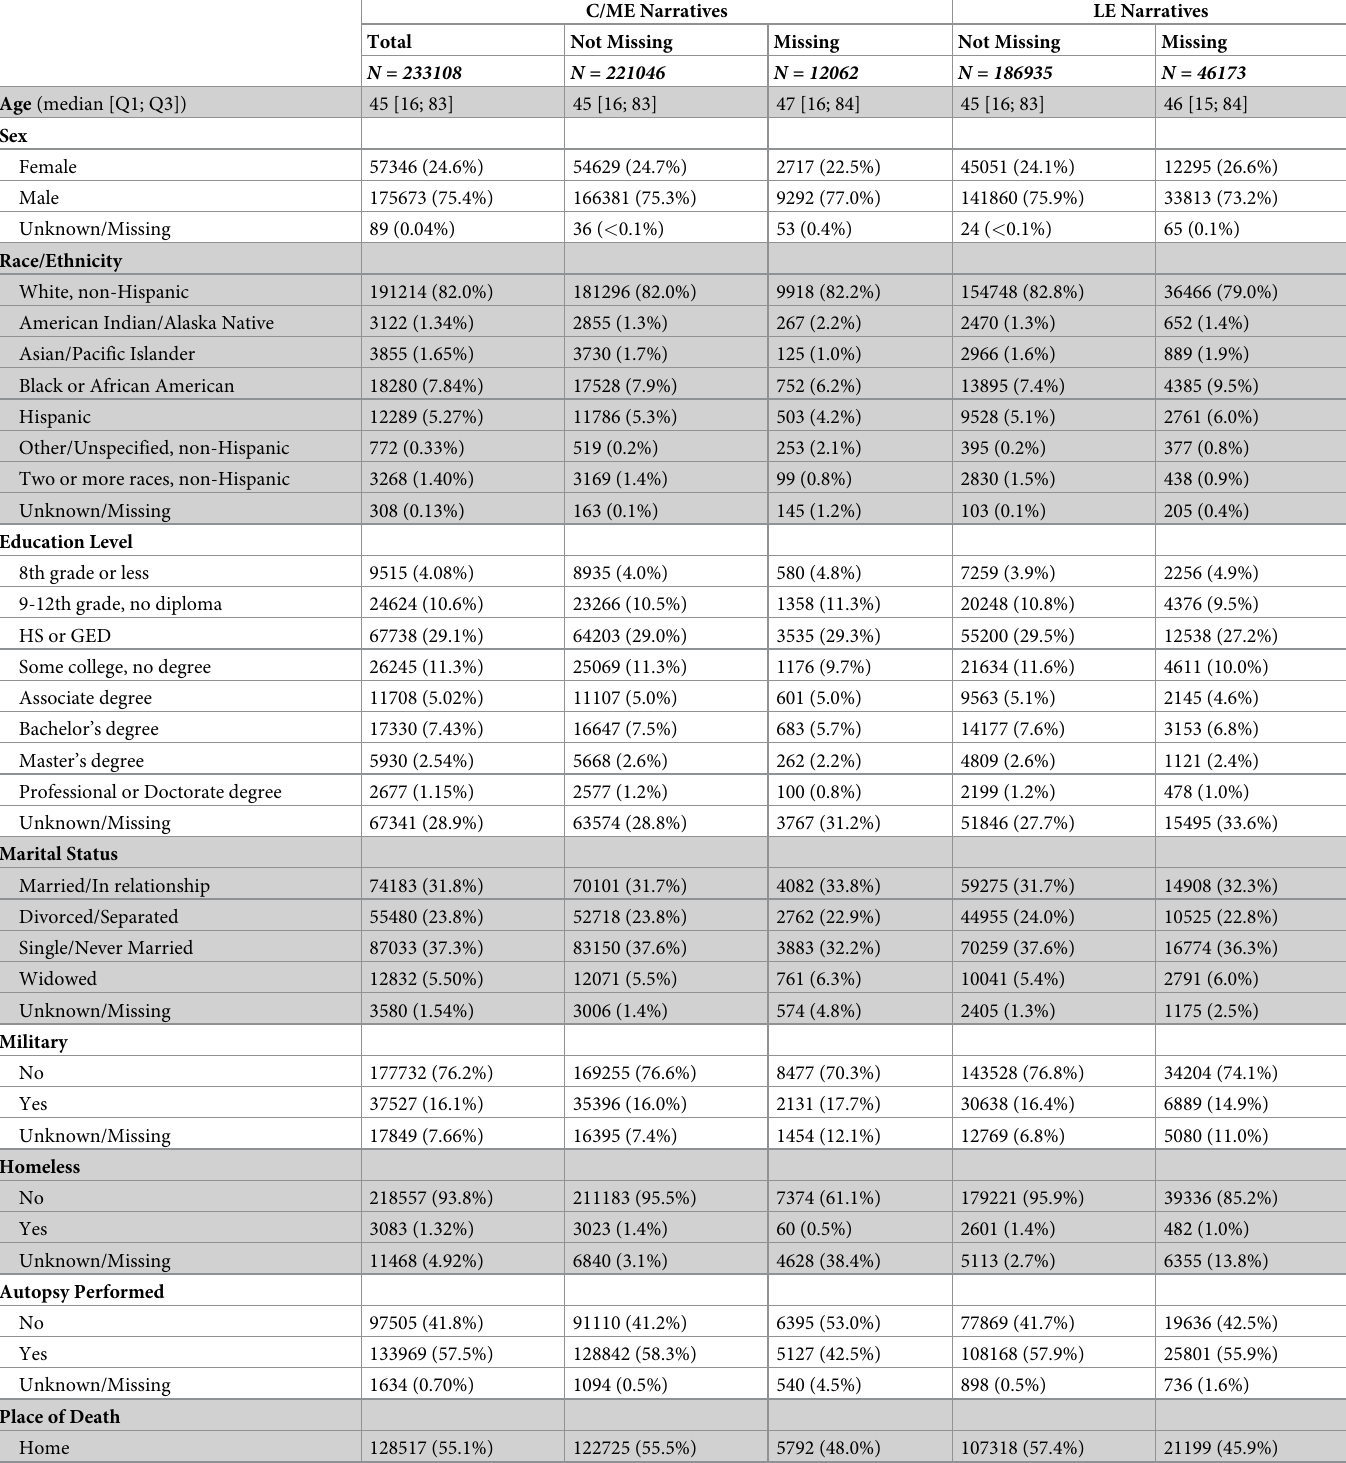
Table 1. Decedent characteristics stratified by narrative missing status: Suicide and undetermined deaths in the National Violent Death Reporting System, 2003–